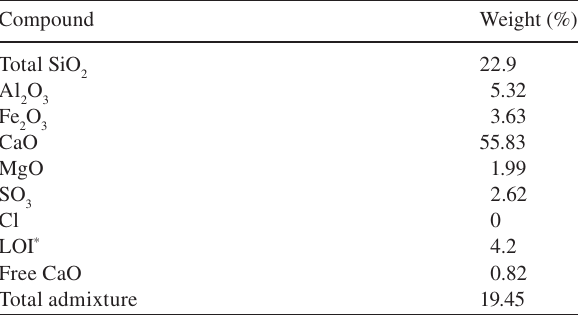
Table 2 Chemical analysis of the Portland cement used.